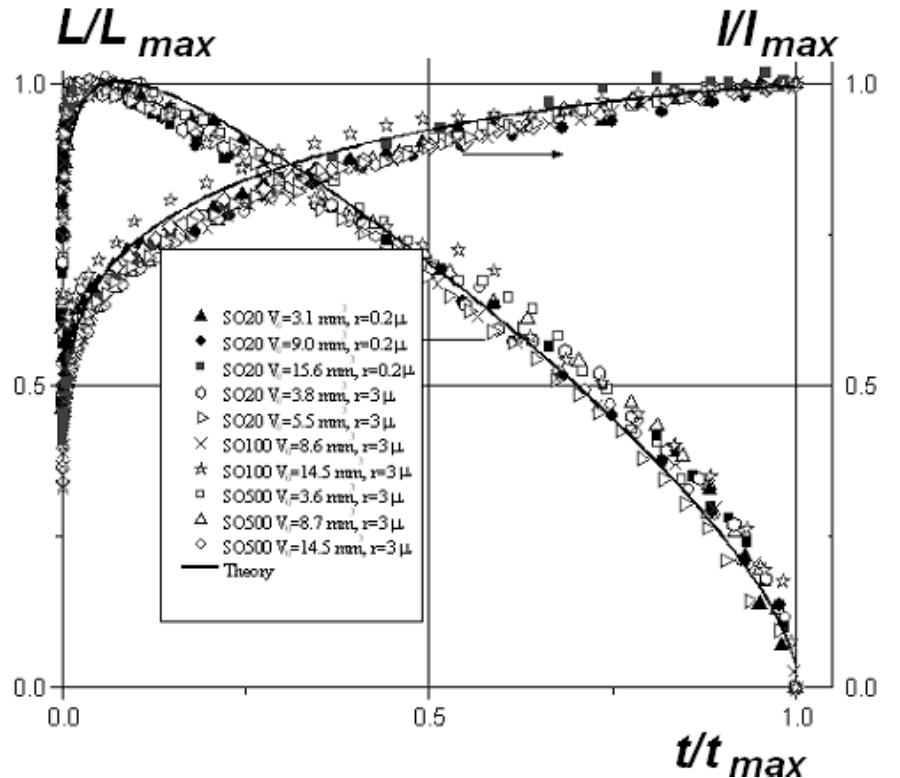
Figure 4. The same as in Figure 3 but using dimensionless co-ordinates: where L max is the maximum value of the drop base, which is reached at the moment t m . The scale l max the time scale t max are given in [13]. Solid lines according to the theoretical equations in [14].